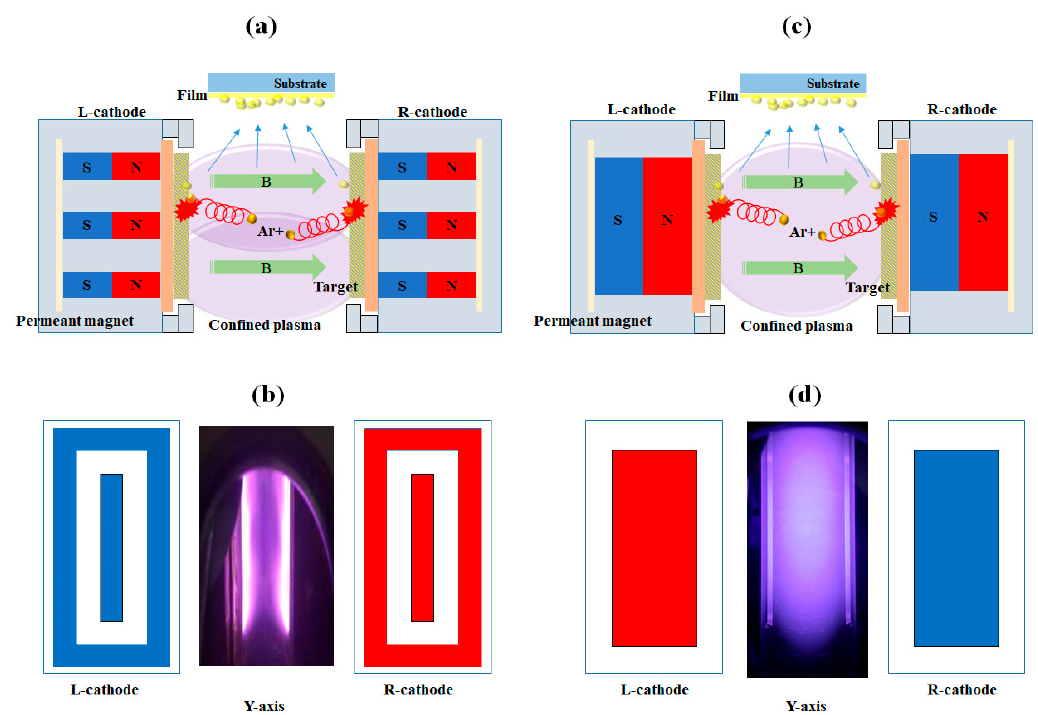
Figure 1. Schematic diagram of facing target sputtering (FTS) system with various magnet arrays. ( a ) and ( b ) Open-type FTS, ( c ) and ( d ) Closed-type FTS.